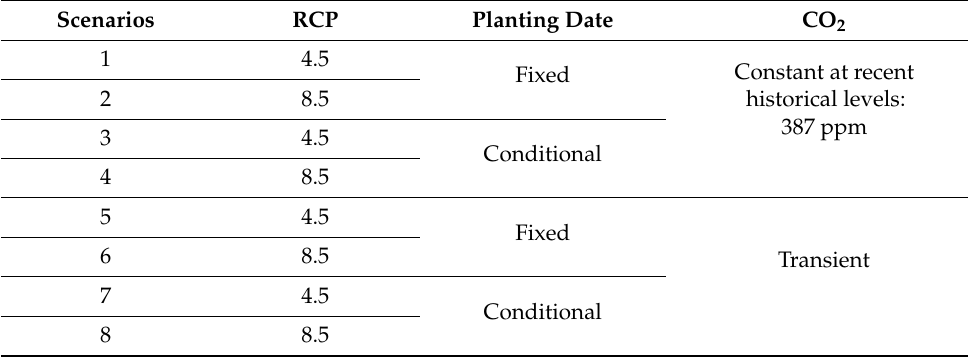
Table 1. Simulation scenarios used in this study.